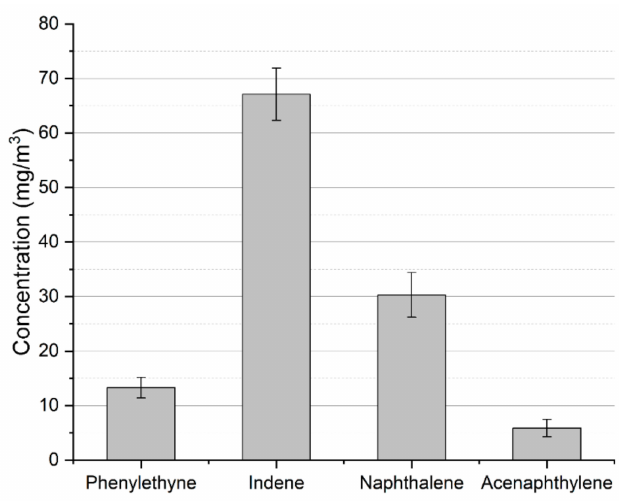
Figure 4. Heavier aromatic byproducts of toluene conversion in MW